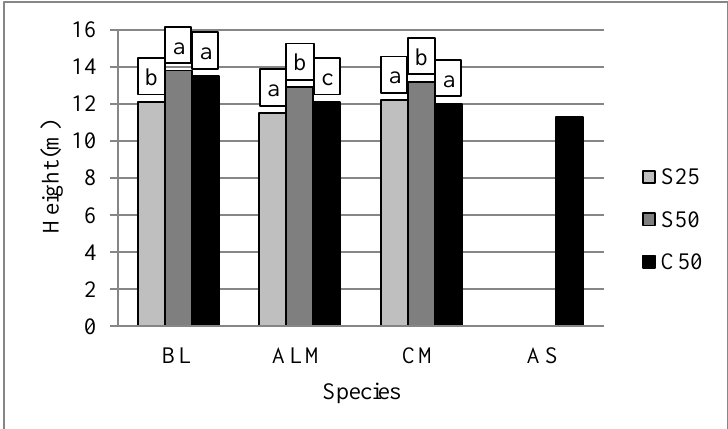
Figure 4. Median heights of the studied tree species in individual groups of research plots. Notes: BL, ALM, CM, AS — explanations as in Figure 2, different letters indicate significant differences ( p ≤ 0.05) according to the K – W test between treatments within a species.